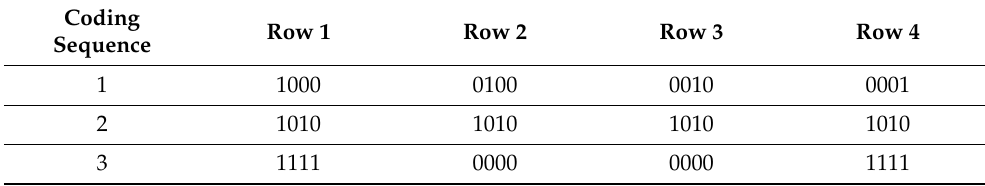
Table 2. Coding sequences pattern for 4